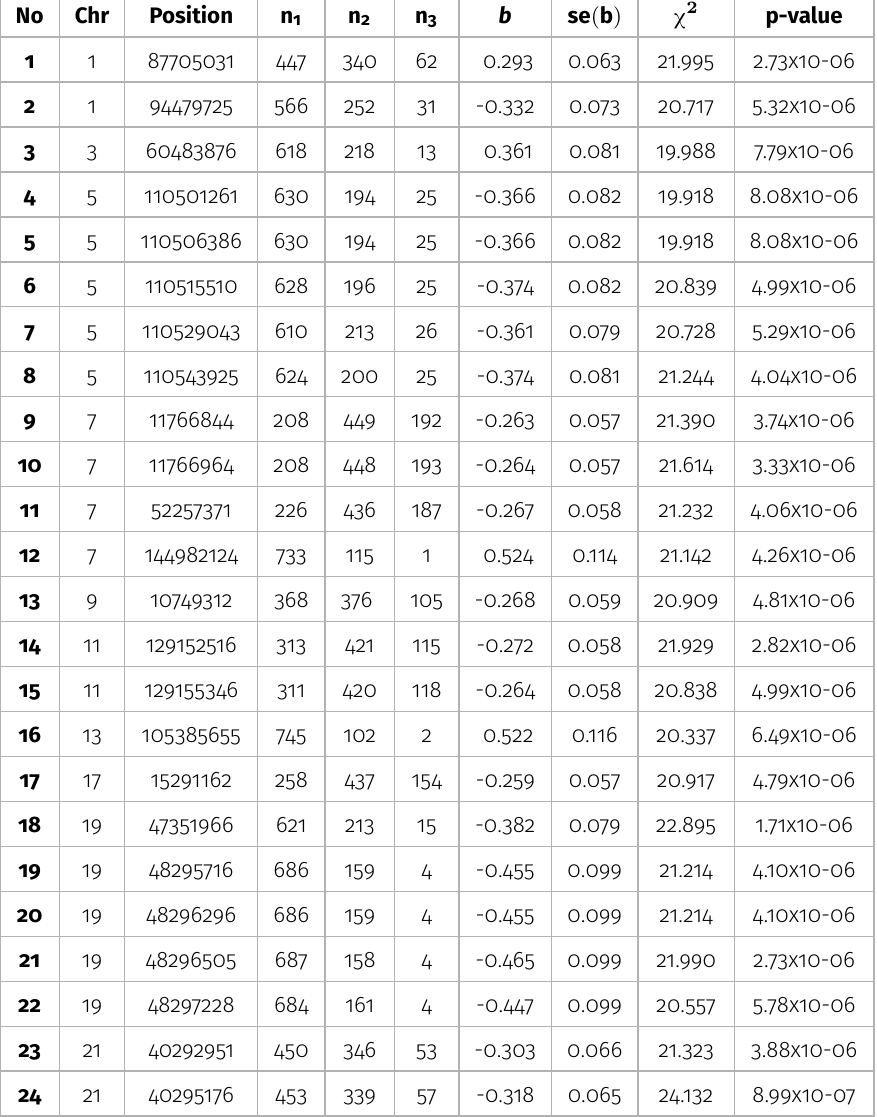
Table II. Results for top associated 25 variants (listed according to chromosomal